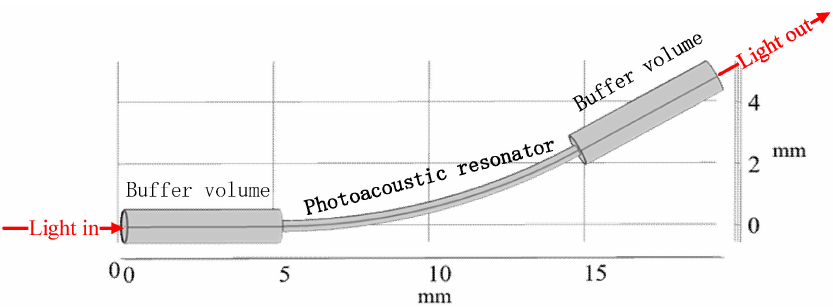
Figure 2. The proposed flexible longitudinal photoacoustic cell including a curved photoacoustic resonator and two buffer